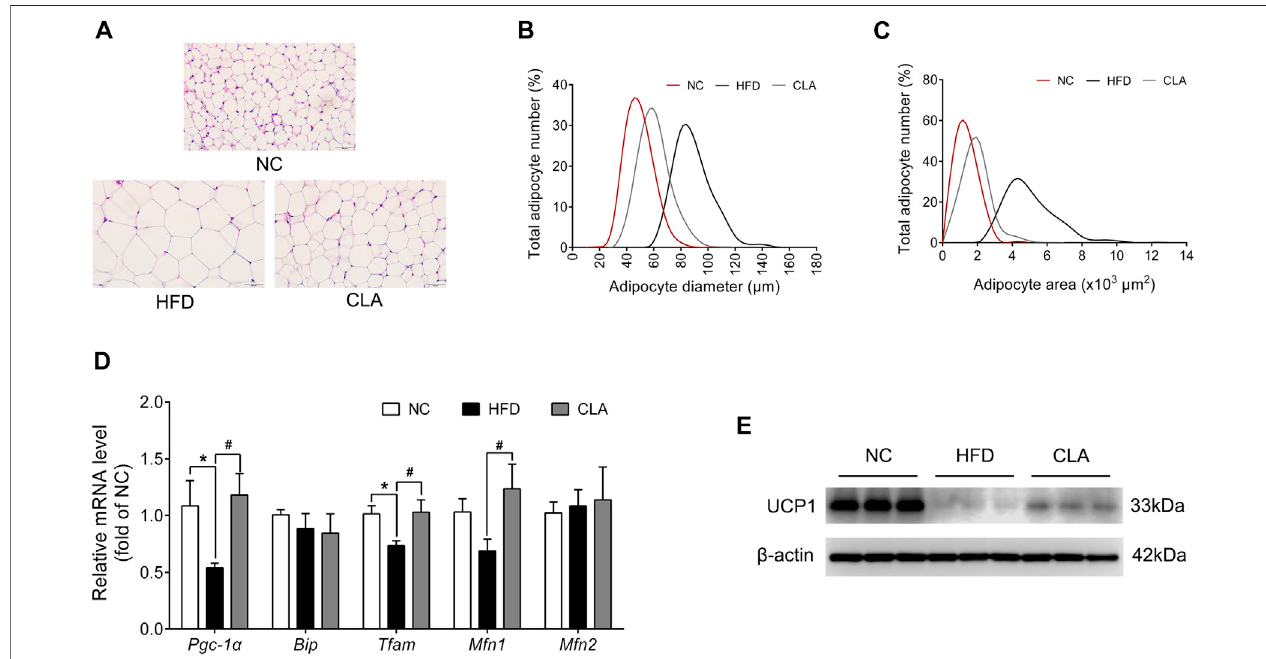
FIGURE 5 | Effect of CLA on the iWAT function of mice fed a HFD. (A) Representative H and E staining of iWAT sections. Original magni fi cation, × 400. Scale bar, 50 μ m. (B) Adipocyte diameter and (C) Adipocyte area are shown ( n (cid:2) 6). (D) mRNA levels of Pgc-1 α , Bip , Tfam , Mfn1 , and Mfn2 normalized to β -actin ( n (cid:2) 6). (E) Detection of UCP1 by Western blotting ( n (cid:2) 3 in each group). * p < 0.05 vs. NC; # p < 0.05 vs.